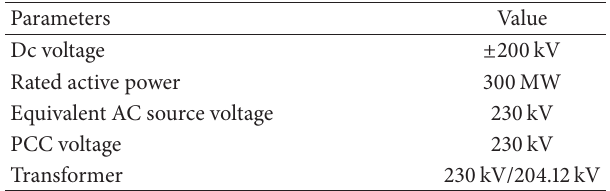
Table 6: Parameters of test